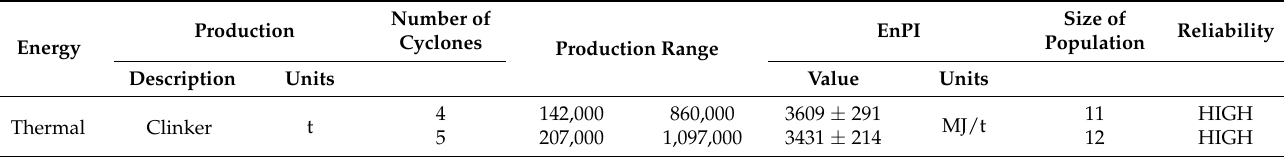
Size of EnPI Reliability Population